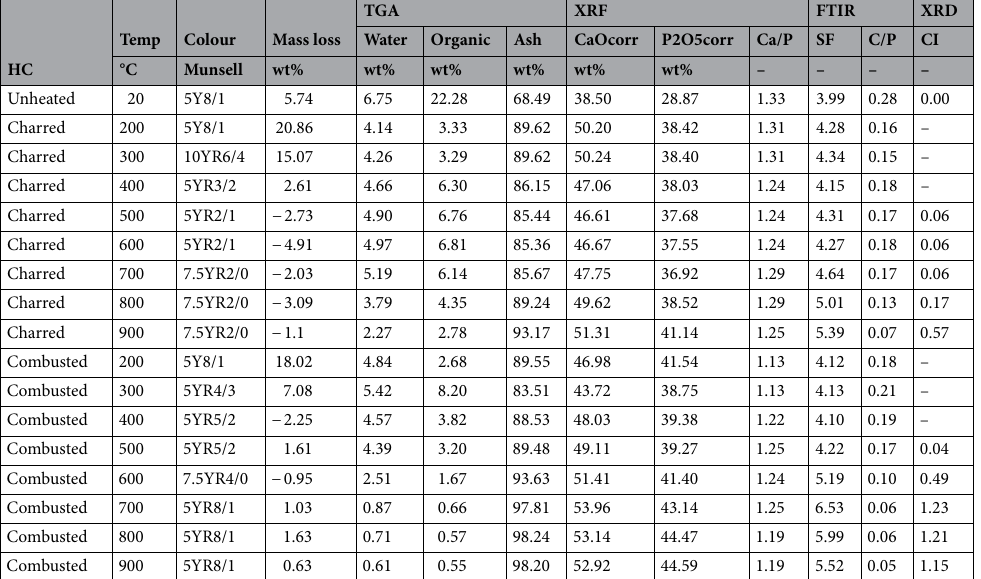
Table 3. Overview table showing the numeric results for the samples exposed to pH 12 conditions, per analytical technique. For the XRF results the TGA-corrected values are displayed. A dash (–) indicates that particular samples were not analysed for that technique.